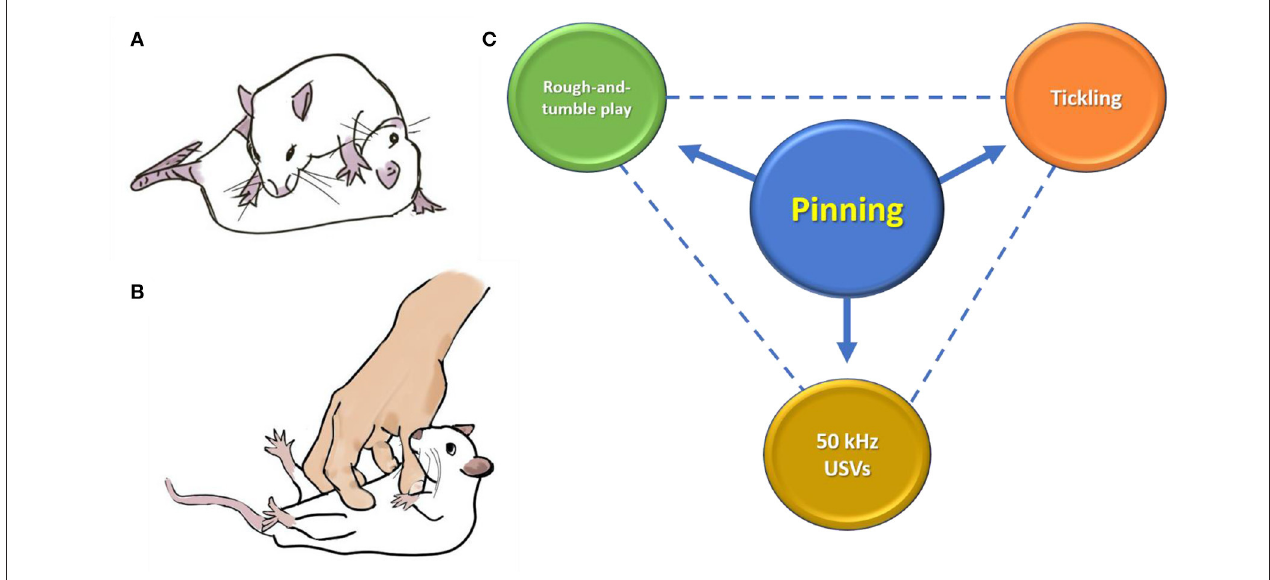
FIGURE 1 | (A) Pinning is a component of social play in rats, where one rat has its dorsal surface pinned to the ground, while the other rat is in a dominant posture above. (B,C) Pinning has become the main component of the methodology used when tickling rats, as it elicits 50-kHz ultrasonic vocalizations (USVs). Pinning has been used in the past as a means to quantify rough-and-tumble play between rats ( 14). However, rough-and-tumble play is much more than just pinning, and USVs during pinning are frequent when being tickled by a human ( 1), but less so when being pinned during play (10, 15). Drawings are by Tayla J.